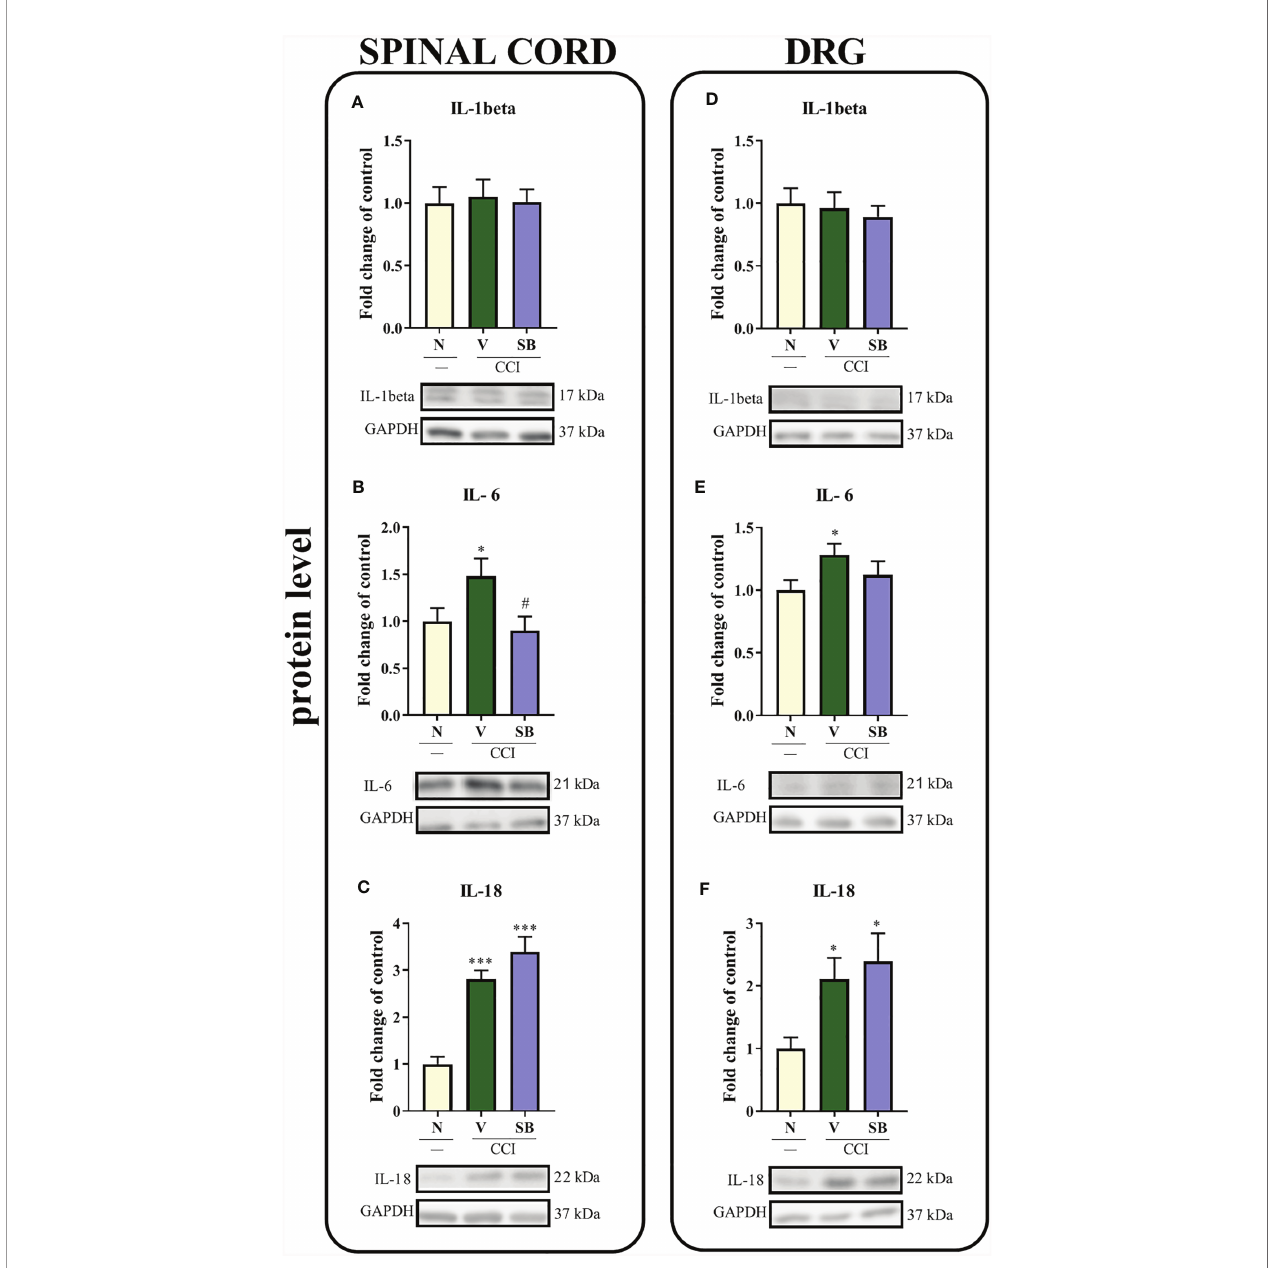
FIGURE 5 | Effects of repeated administration of SB328437 (SB, 10 m g/5 m l; i.t .) 16 h and 1 h before CCI and then once a day for 7 days on the levels of the IL-1 beta (A, D) , IL-6 (B, E) and IL-18 (C, F) proteins in the spinal cord (A – C) and the DRG (D – F) on the 7 th day post- chronic constriction injury of the sciatic nerve (CCI) in rats. The data are presented as the mean fold changes relative to the control ± SEM (6 – 8 samples per group). Intergroup differences were analyzed using ANOVA with Bonferroni ’ s post hoc test for multiple comparisons. *P < 0.05 and ***P < 0.001 indicate a signi fi cant difference compared with the control group (naive, N rats); # P < 0.05 indicates a signi fi cant difference compared with the Vehicle (V)-treated